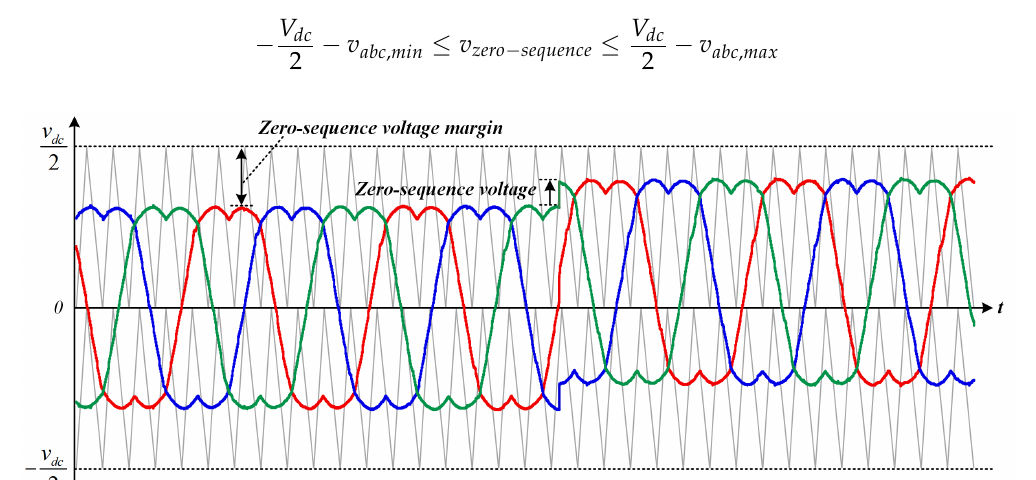
Figure 5. Applicable range and limit of zero-sequence